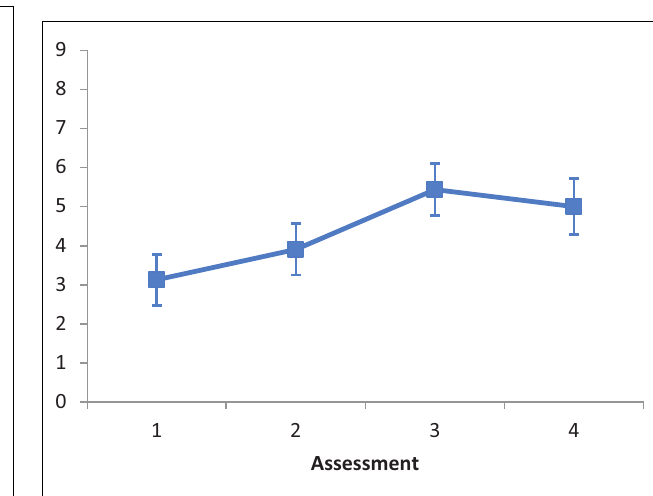
FIGURE 3 | LN patients’ performance on the Menu Reading subtest as a function of assessment . Error bars represent 1